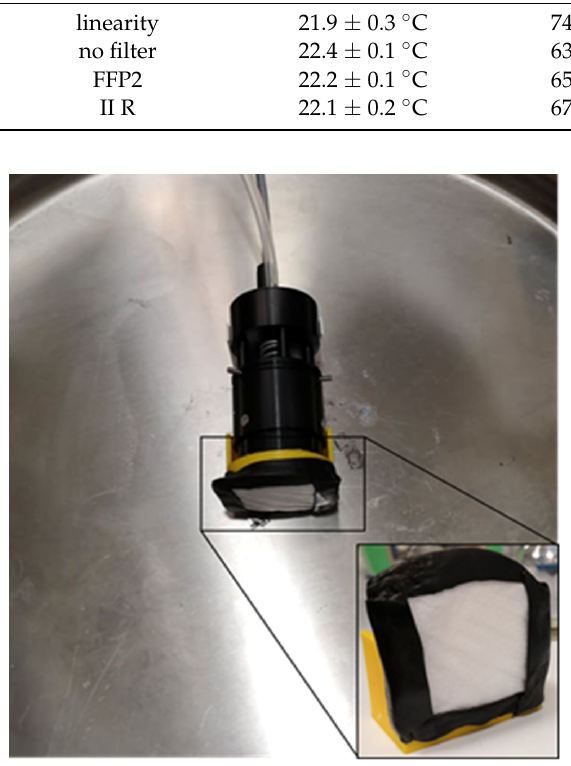
Table 1. Experimental conditions during measurements for linearity experiments, without filter (no filter), and with FFP2 mask and II R mask. The range of the radon activity concentration is described as c(Rn). Experiment Temperature Relative Humidity